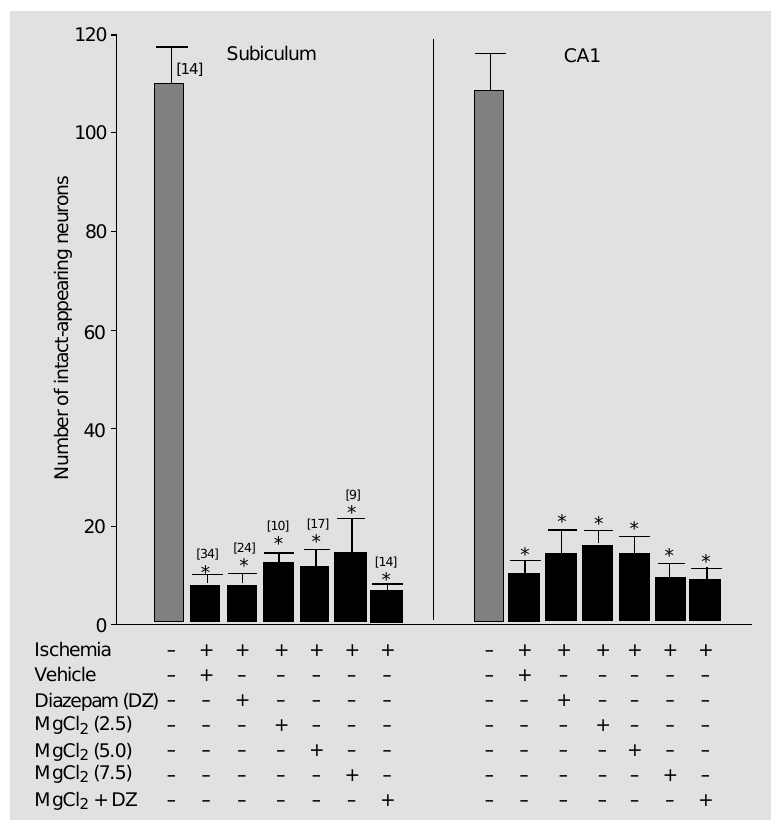
Figure 1 - Effect of MgCl 2 (2.5, 5.0 or 7.5 mmol/kg, sc ) either alone or in combination with diazepam (DZ) (MgCl 2 + DZ, 5 mmol/kg and 10 mg/kg, ip , respectively) on hippocampal pyramidal cell loss after 15-min transient forebrain ischemia. The effect of 5.0 mmol/kg MgCl 2 was tested after a single dose (1x, 2 h post-ischemia) or multiple (4x, 1, 2, 24 and 48 h post-ischemia) doses. The 2.5 and 7.5 mmol/kg MgCl 2 doses were tested after multiple administration (4x) only. The animals treated with a single dose (1x) or multiple (4x) doses of MgCl 2 (5.0 mmol/kg) were pooled, as were the groups treated with MgCl 2 (1x) + DZ or MgCl 2 (4x) + DZ. Diazepam (10 mg/kg), alone or in combination with MgCl 2 , was always given twice (1 and 2 h after reperfusion). Bars and vertical lines represent the mean and SEM. The numbers within brackets indicate the sample size. *P<0.0001 vs the sham- operated